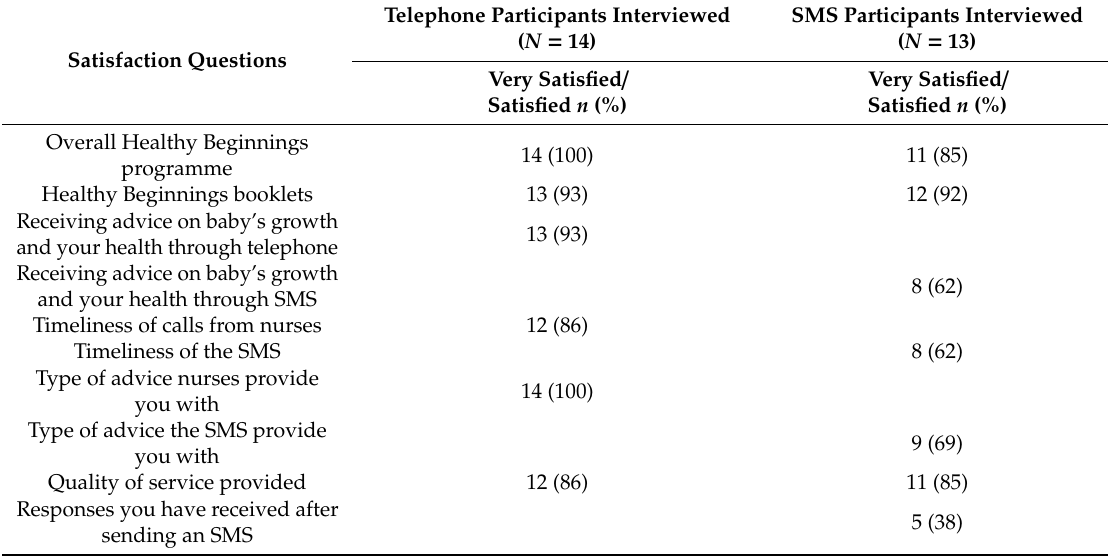
Table 4. Satisfaction of participants (who were interviewed) with program and program contents at the six-month